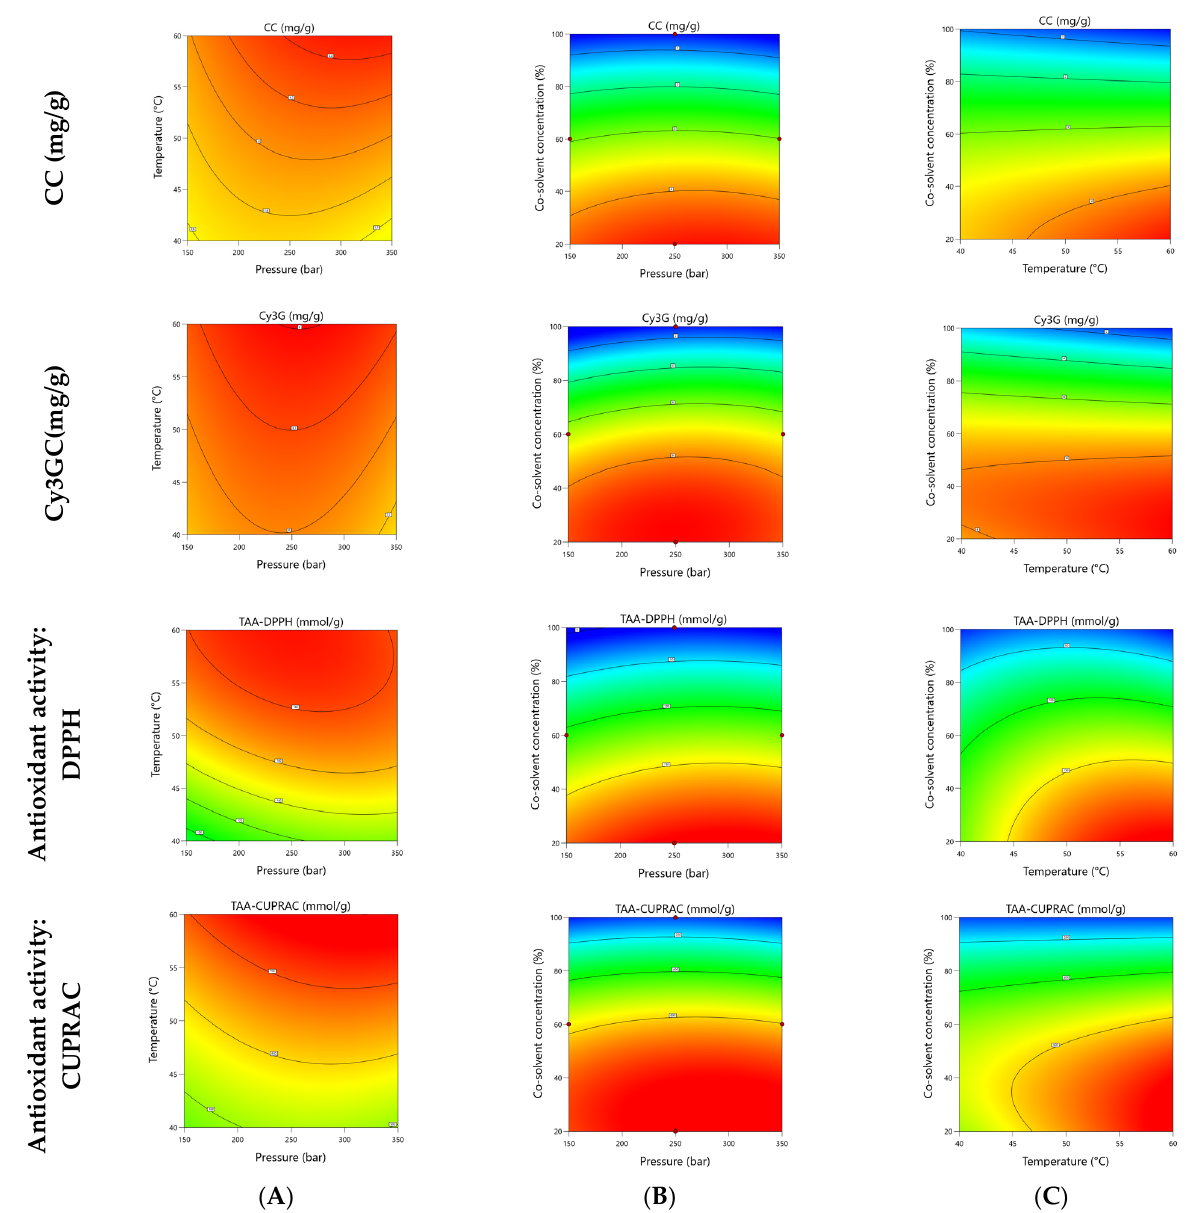
Figure 2. Contour plots for the interactive effects of ( A ) pressure and temperature; ( B ) extraction pressure and co-solvent concentration; ( C ) temperature and co-solvent concentration on the catechin- (CC), cyanidin-3-O-glucoside contents (Cy3GC), and total antioxidant activity (DPPH and CUPRAC assays) in black rosehip. The excluded variable was fixed at its optimal point.